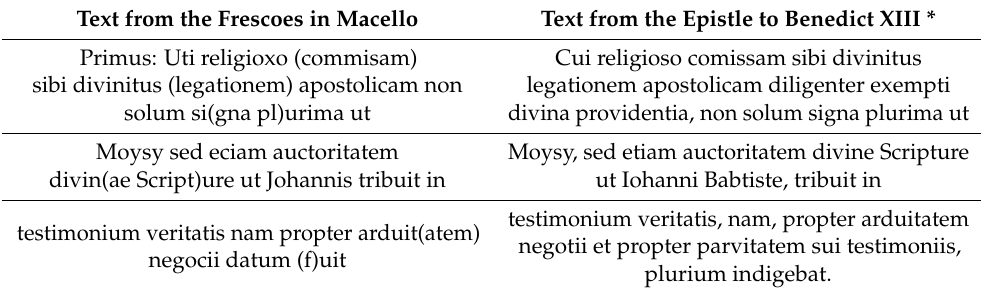
Table 2. Textual comparison, banderole 2 in the vision of beatus Vincentius. Text from the Frescoes in Macello Text from the Epistle to Benedict XIII